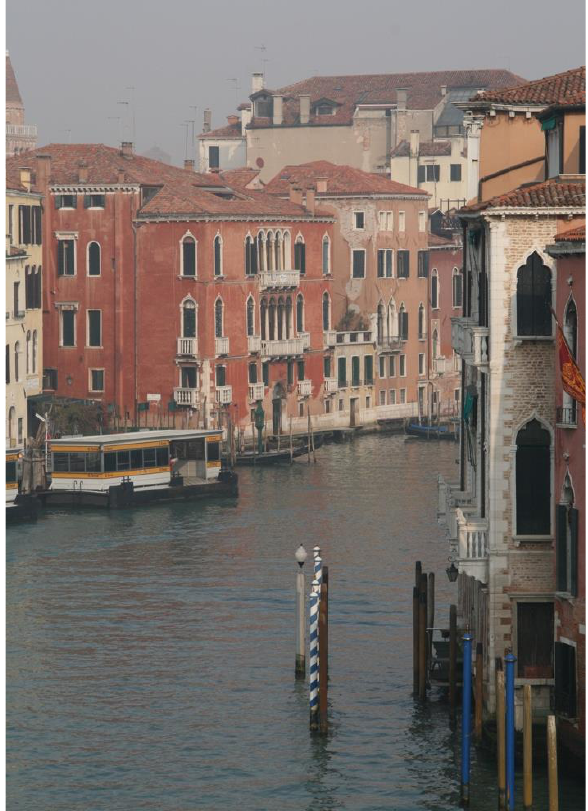
Figure 2. View of the building fronts with historical plasters in San Tomà on the Grand